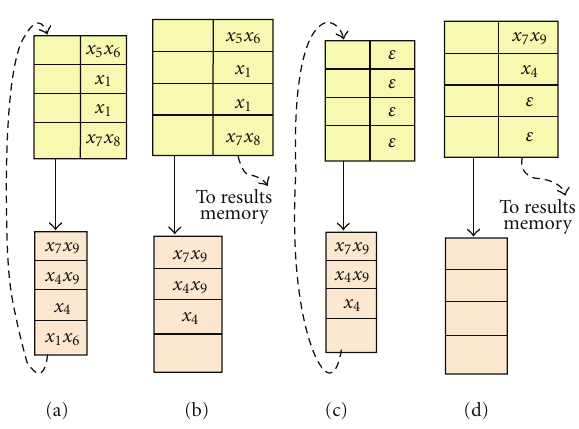
Figure 6: Contents of systolic array and overflow FIFO for the shown sequence X (a) after first pass, (b) after second pass (OF to array refeed), (c) systolic array is emptied for new OF refeed, (d) after final refeed from OF. Dotted lines illustrate the paths of data refeed.